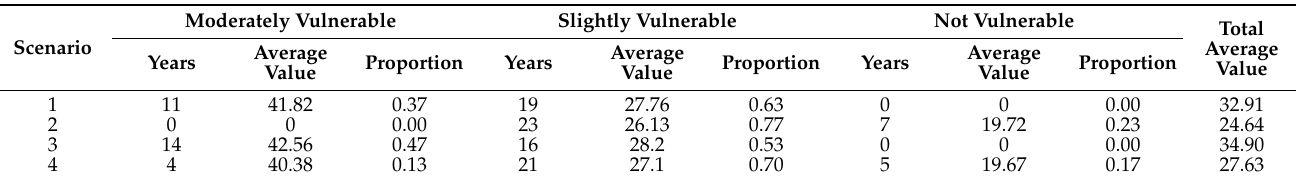
Table 6. Vulnerability grade comparison of different